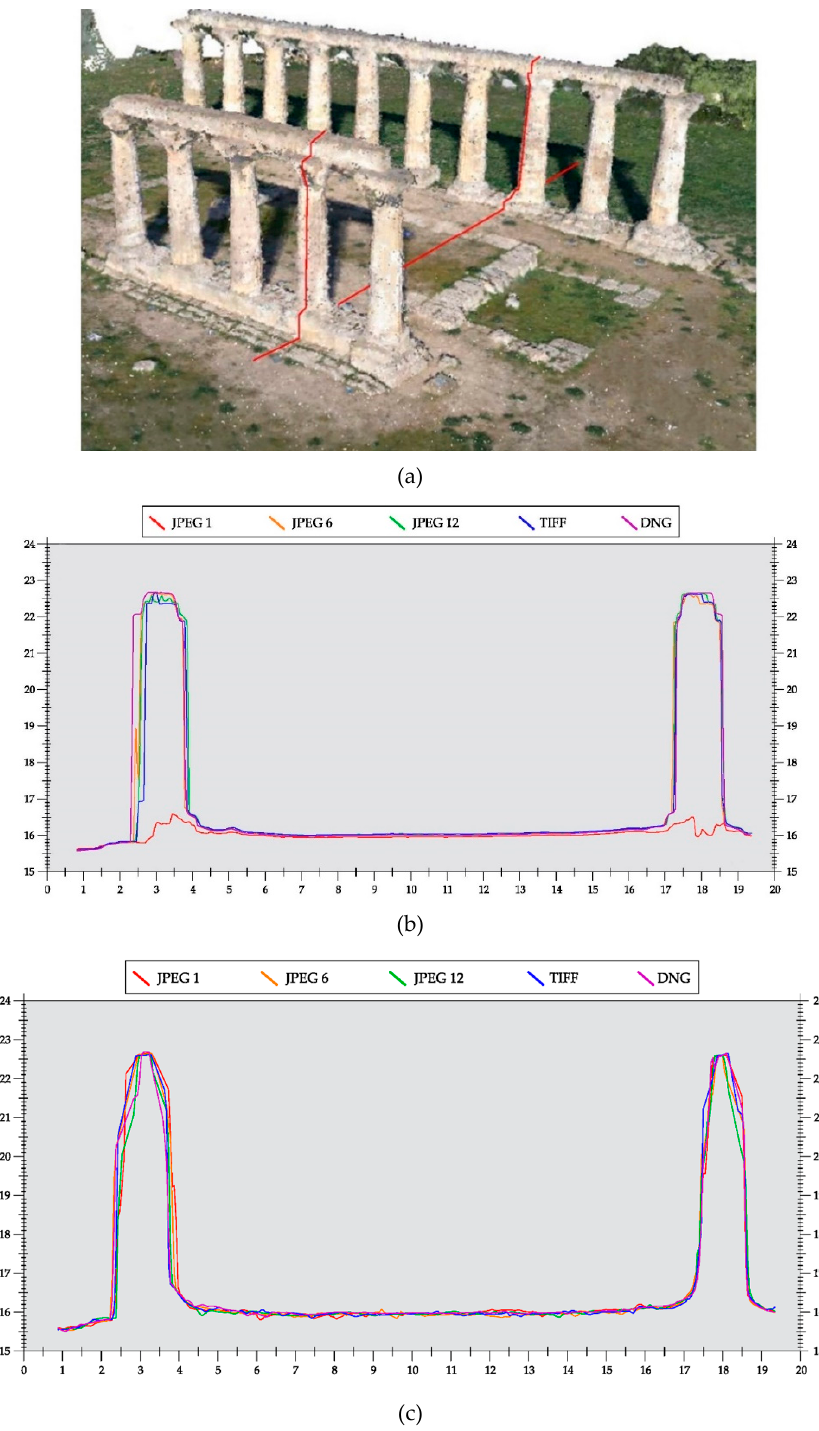
Figure 5. Comparison of point clouds in a section of the temple: ( a ) 3D point cloud with the identification of the section, ( b ) sections indicated with different color obtained from Agisoft Metashape, and ( c ) 3DF Zephir.